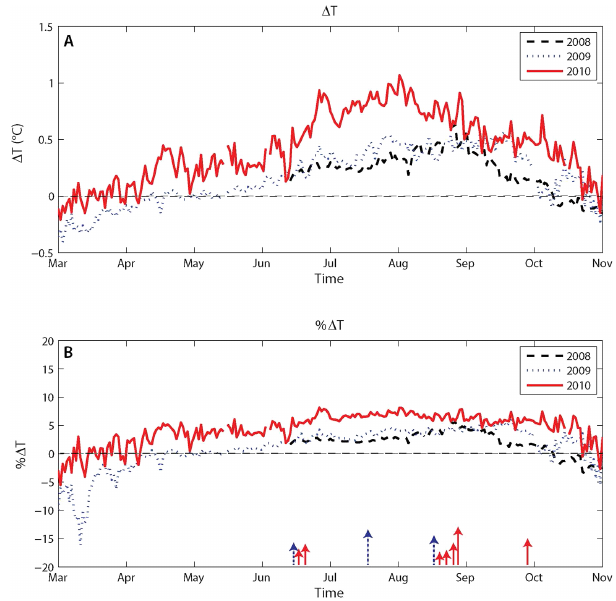
Figure 5. (a) Reach-scale change in temperature ( (cid:49)T ) calculated from temperatures at the reach outflow (PT1252) minus the temper- ature at the reach inflow (PT515). (b) % (cid:49)T is the percent change relative to the temperature at the inflow location (PT515). Positive values represent warming throughout the reach and negative val- ues represent cooling relative to the upstream inflow temperature at PT515. Arrows represent time of individual beaver dam construc- tion. Blue and red arrows correspond with years 2009 and 2010, respectively, while the arrow size is proportional to size of the